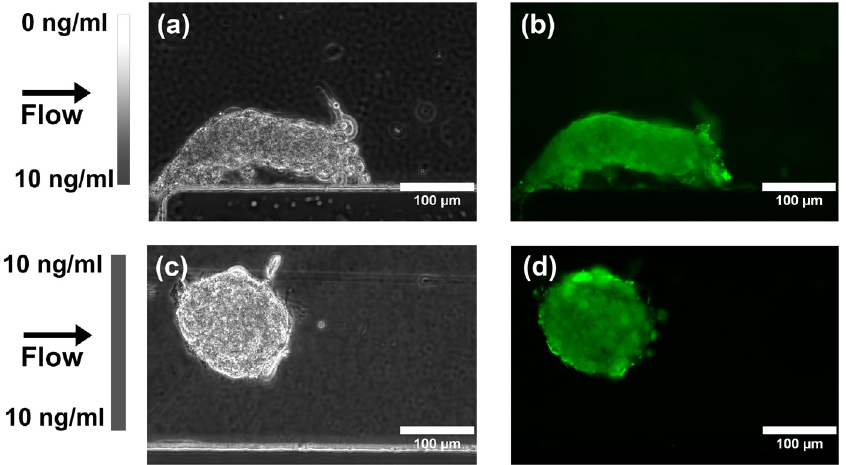
Figure 9. Effect of TGF- β1 gradients on MSC type II coll agen deposition (type II collagen IHC). ( a ) Phase contrast image and ( b ) Fluorescent image showing type II collagen deposition within an MSC aggregate after 21 days in TGF- β1 gradient culture. ( c ) Phase contrast image and ( d ) Fluorescent image showing type II collagen deposition within an MSC aggregate after 21 days in constant TGF- β1 concentration culture. Green is type II